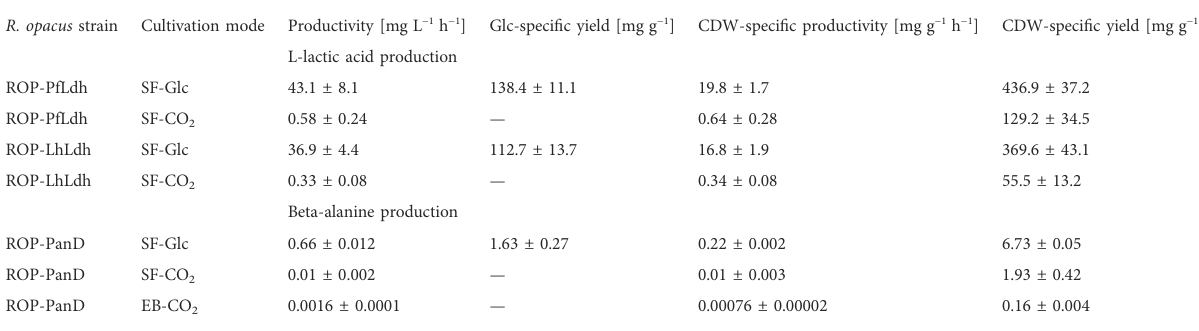
TABLE 2 Volumetric and speci fi c L-lactic acid and beta-alanine production rates of R. opacus strains measured during autotrophic electrobioreactor (EB-CO 2 ) and shake fl ask cultivations with either glucose (SF-Glc) or CO 2 (SF-CO 2 ) as carbon source. In all performed EB-CO 2 trials, L-lactic acid concentrations remained below the detection limit and are not shown here. The shown data is determined from triplicate measurements (i.e., three individualtransformantcultivationsperstrain)andtheCDW-speci fi cproductivitywasdeterminedfromdatarecordedfromthecultivationstartuntil the time of measured maximum product concentration (see Figures 3,